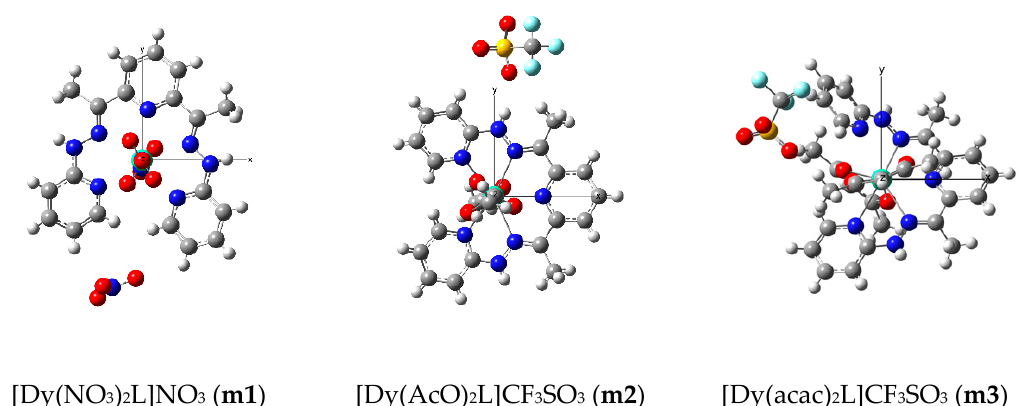
Figure 8. Model structures m1 – m3 for complexes 1 – 3 , respectively. Table 2. Calculated atomic spin densities assigned to each f orbitals.